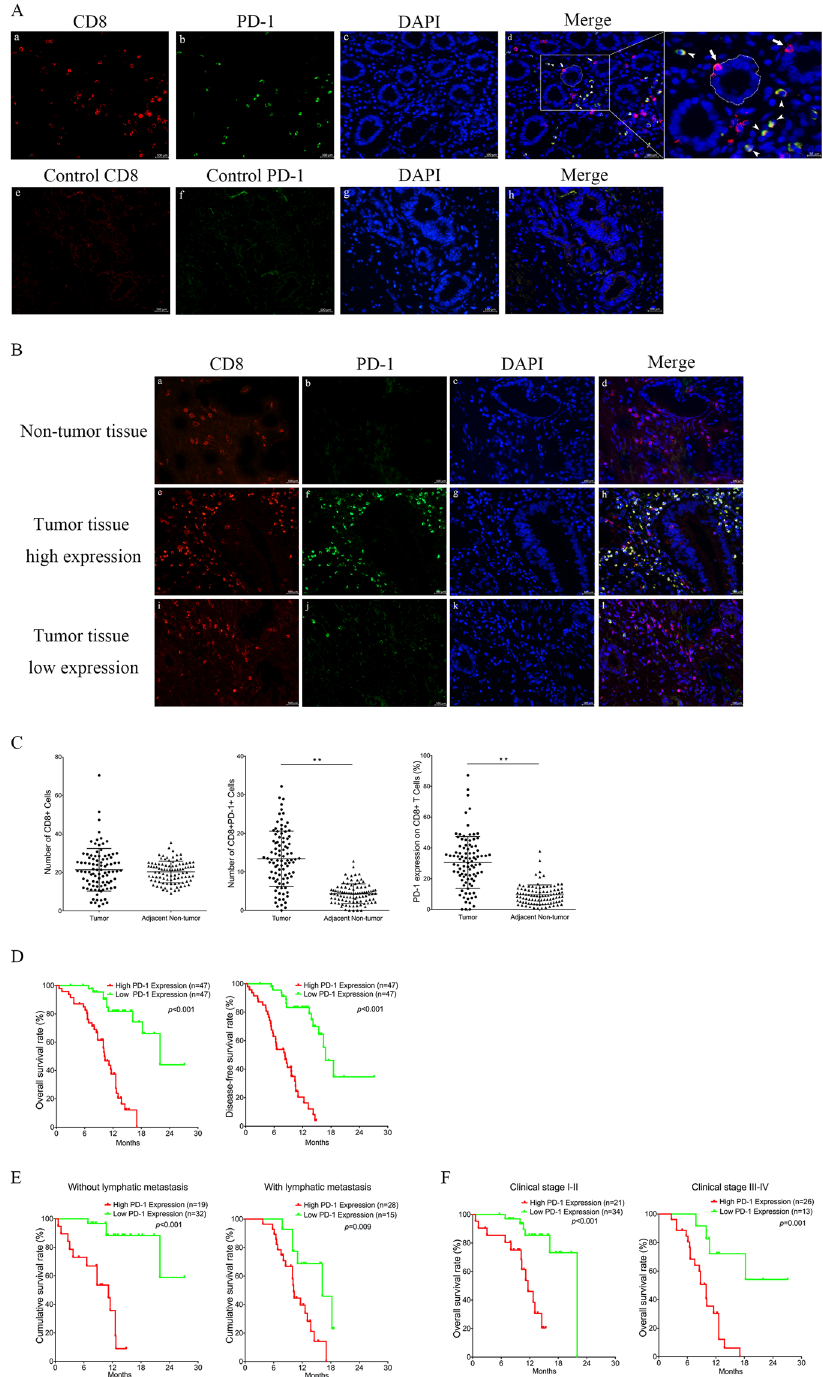
Figure 1. Level of PD-1 expression on CD8 + T cells in PDAC tissue samples and its correlation with overall survival rate in pancreatic ductal adenocarcinoma patients. ( A ) Tissues derived from surgical resection of PDAC patients were stained with antibodies to human CD8 (red) (a) and PD-1 (green) (b) and counterstained with DAPI (blue) (c). Isotype control antibodies for anti-PD-1 and anti-CD8 were included in each experiment (e, f). The merged graph (d) shows that the pancreatic duct (dotted line) was mainly infiltrated with CD8 + T cells (arrows) whereas stroma was mainly infiltrated with PD-1 + CD8 + T cells (arrowheads) (original magnification, × 400). A representative experiment is shown in B. Quantitative measurement of CD8 + and PD-1 + CD8 + Tumour-infiltrating lymphocytes (TILs) was performed in at least four random high power fields ( × 400), and the expression level of PD-1 on CD8 + TILs was calculated as follows: expression level, % = (PD- 1 + CD8 + TILs/CD8 + TILs) × 100. For quantitative variables, the median was used as a cut-off. Mean ( ± SD) number of infiltrated PD-1 + CD8 + T cells and CD8 + T cells and mean ( ± SD) expression of PD-1 protein on tumour-infiltrating CD8 + T cells from 94 paired samples of PDAC tumour tissues and adjacent